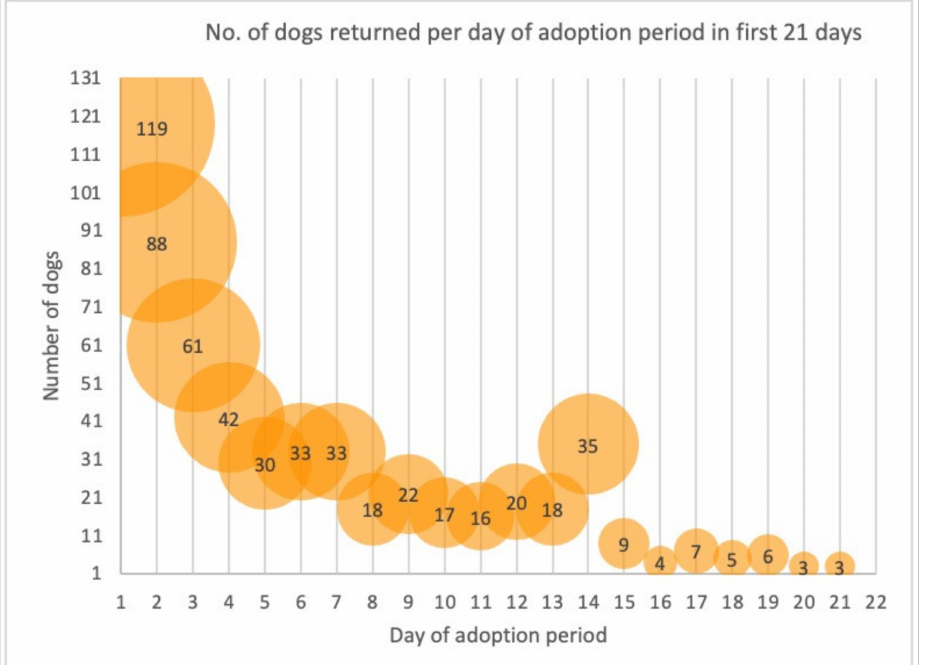
Figure 1. Distribution of the numbers of adopted dogs that were readmitted to RSPCA Queensland in 2019 and 2020 during for the first 21 days of their adoption period; day of adoption is day 1; 119 dogs were readmitted on the day of their adoption, 88 on the next day (the second day of their adoption period), and so